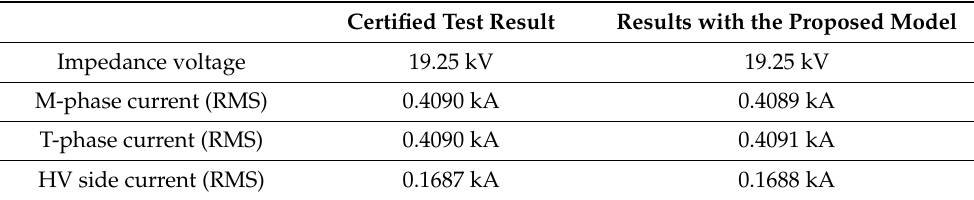
Figure 11. Result of impedance voltage test for the proposed Scott transformer: ( a ) three-phase current waveforms; ( b ) M- and T-phase current waveforms and vector representation. Table 3. Result of impedance voltage test (a comparison of the result with the certified test report of an actual Scott transformer by